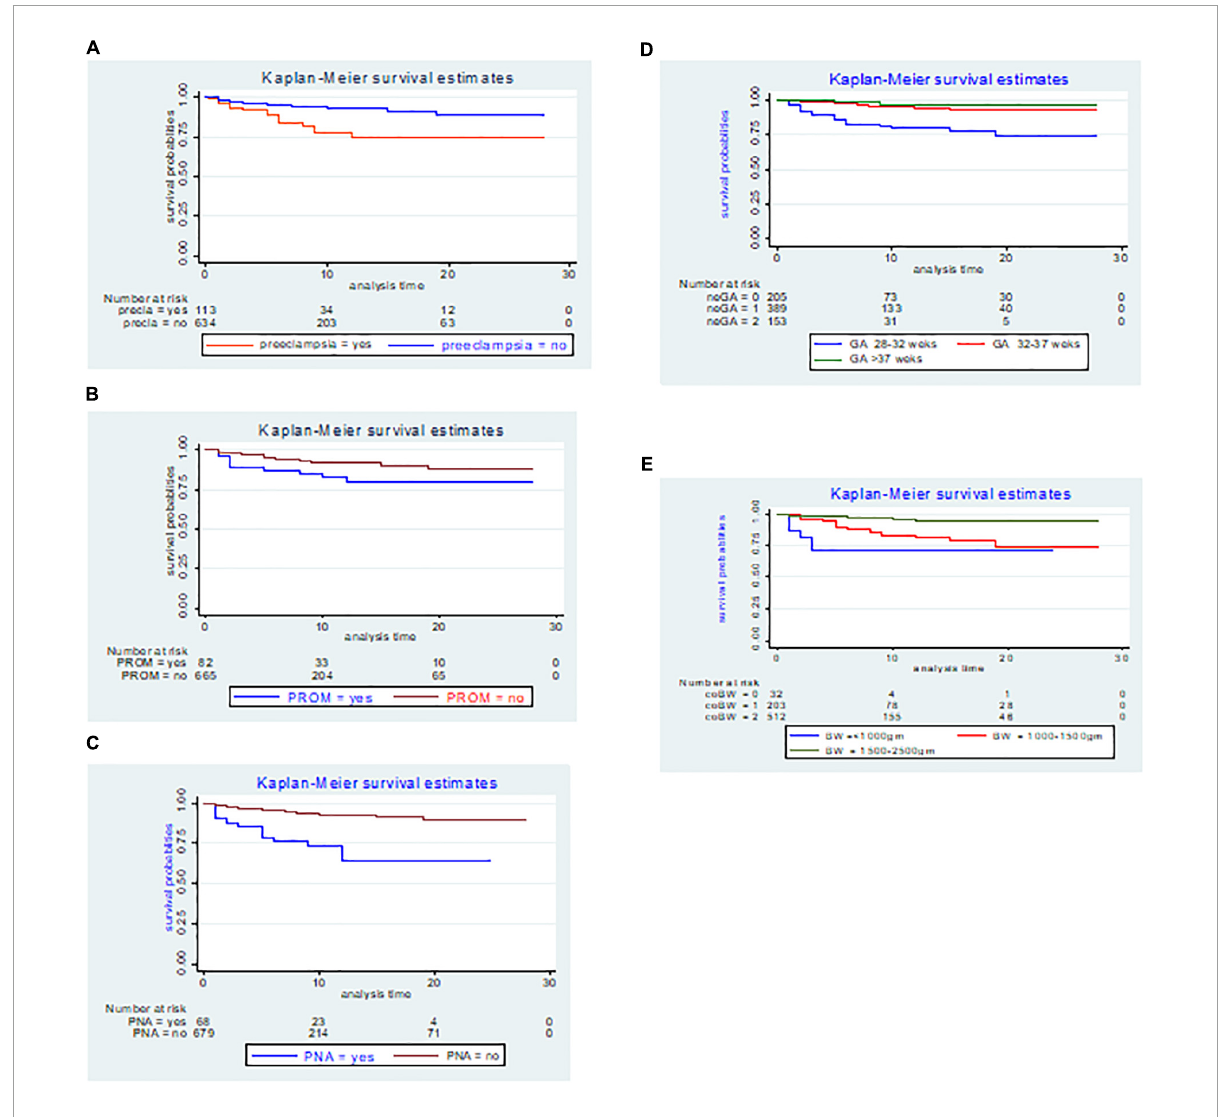
FIGURE3 The Kaplan–Meier incidence estimate of NEC with respect to (A) preeclampsia, (B) premature rupture of membranes (PROM), (C) perinatal asphyxia (PNA), (D) gestational age, and (E) birth weight LBW neonates admitted to the NICU of FHCSH, Ethiopia from 1 January 2015 to 30 December